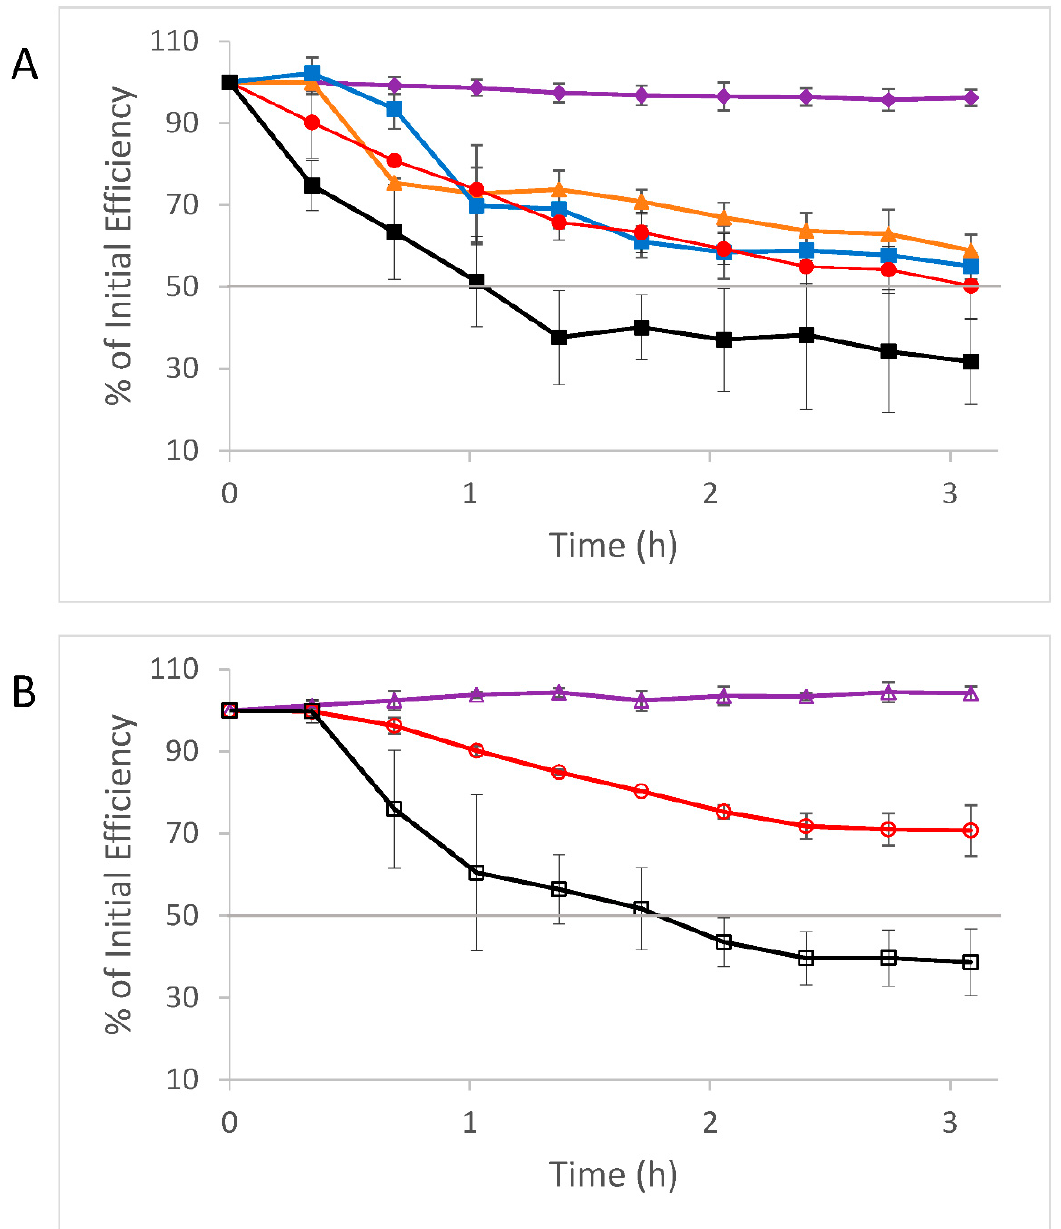
Figure 4. Accelerated stability test results for eight different stationary phases shown as % of initial efficiency vs. time exposed to the basic solution. The columns were exposed at 70 ◦ C to a solution containing acetonitrile and aqueous w w pH 11.30 ammonium bicarbonate, with a 60/40 v / v ACN/buffer ratio, s w pH 10.87. The average results for three replicate columns are shown with error bars indicating + one standard deviation. ( A ) Unbonded silica or BEH materials (purple diamonds, BEH HILIC; orange triangles, Accucore HILIC; blue squares, CORTECS HILIC; red circles, Atlantis HILIC; black squares, Ascentis Si). ( B ) Surface-modifed silica and BEH materials (open purple triangles, BEH Amide; open red circles, SeQuant ZIC-HILIC; open black squares, TSKgel Amide-80).